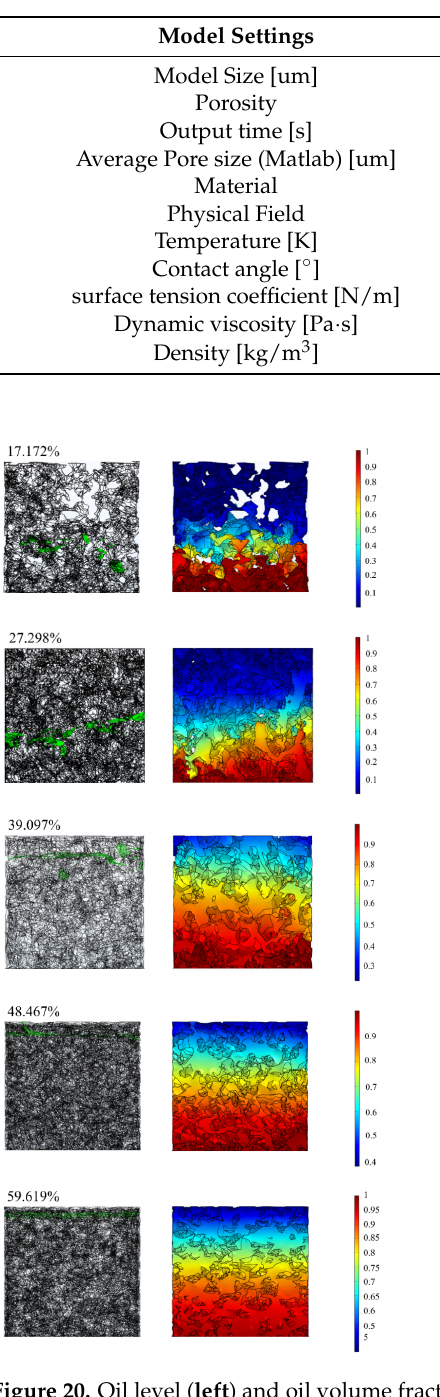
Table 6. The input of the simulation.